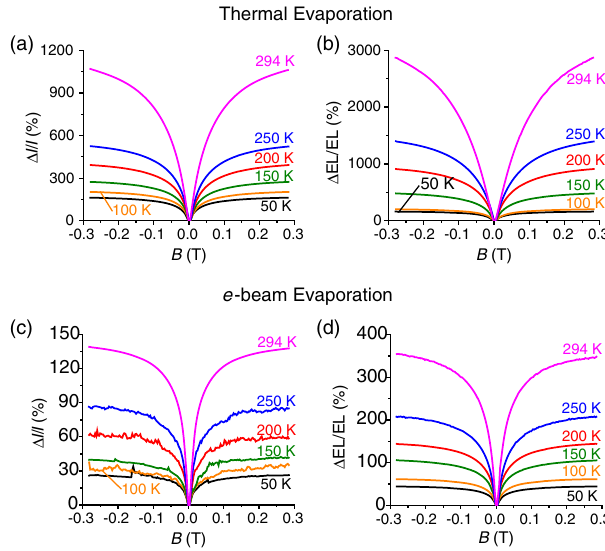
FIG. 9. Magnetoconductance and magnetoelectroluminescence in TADF-exciplex-based devices that differ in the fabrication procedure used to deposit the top metal electrode. (a),(b) Devices whose top electrode is fabricated by thermal evaporation. These devices have been maximally conditioned. (c),(d) Devices whose top electrode is fabricated by e -beam evaporation. These devices are not sensitive to device conditioning.